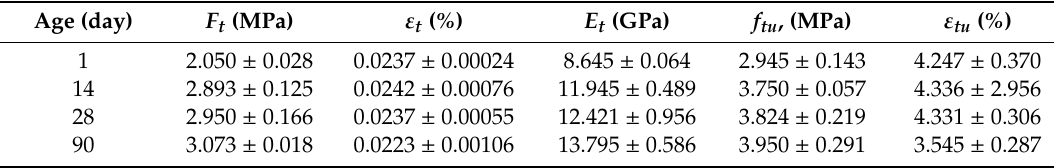
Table 6. Mechanical parameters of SHCC under uniaxial tension.